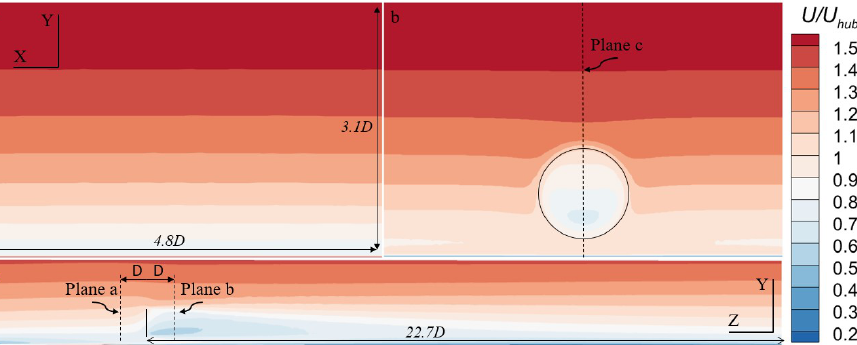
Figure 9. The velocity counter at ( a ) xy plane at z = − 0.5 m ( b ) xy plane at z = 0.075 ( c ) at yz